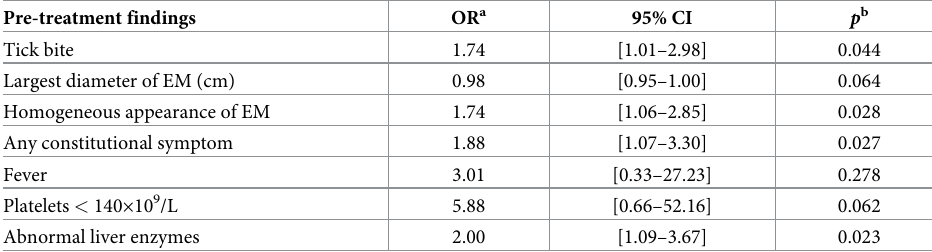
Table 1. Variables related to isolation of borreliae ( Borrelia afzelii or Borrelia garinii ) from blood ( n = 153) or only from skin ( n = 153). Pre-treatment findings OR